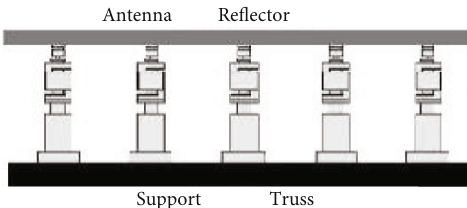
Figure 2: The active adjustment system of a deployable antenna.